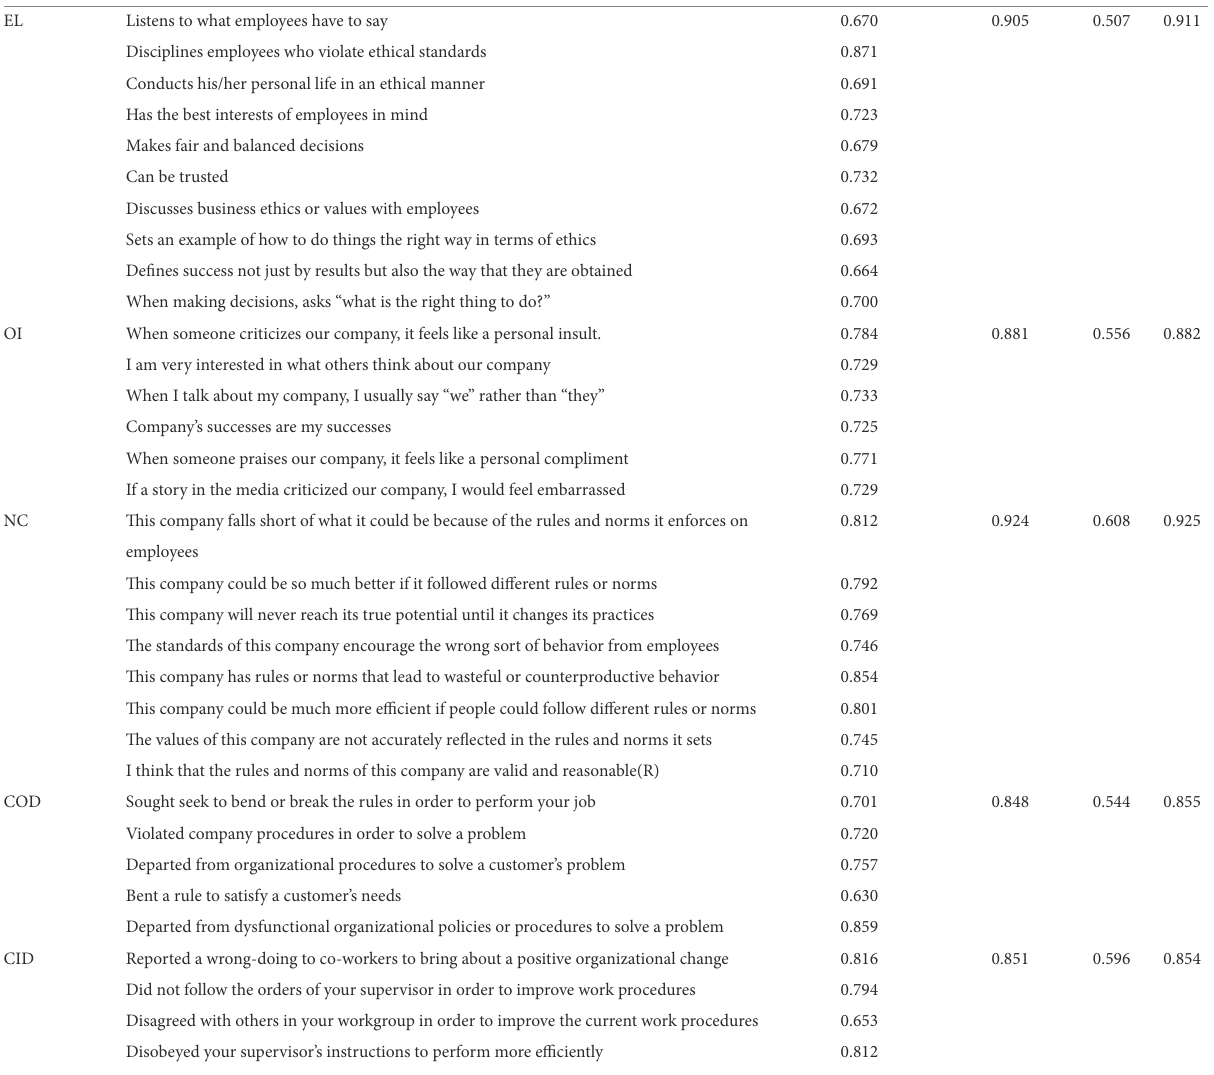
TABLE 3 Reliability and validity (N = 449).